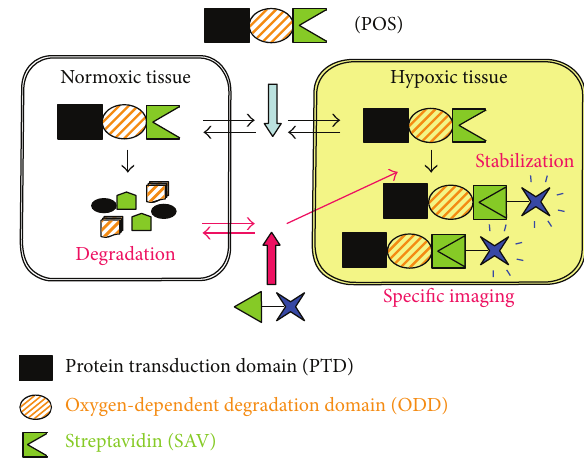
Figure 3: Principle underlying the imaging of HIF-1-active tumor microenvironments, using pretargeted POS and 18 F-FBB. The PTD enables the delivery of POS to all tissues. In normoxic tissues, POS degrades in a manner similar to HIF-1 𝛼 . In contrast, in hypoxic tissues, POS escapes degradation and is retained inside the cells. After allowing sufficient time for POS to degrade in normal tissues, 18 F-FBB is administered. 18 F-FBB enters cells by passive diffusion and binds to the SAV moiety of the POS retained in hypoxic cells; this does not occur in normoxic tissues. Therefore, pretargeting POS followedby 18 F-FBBadministrationenablesspecificimagingofHIF- 1-active hypoxic